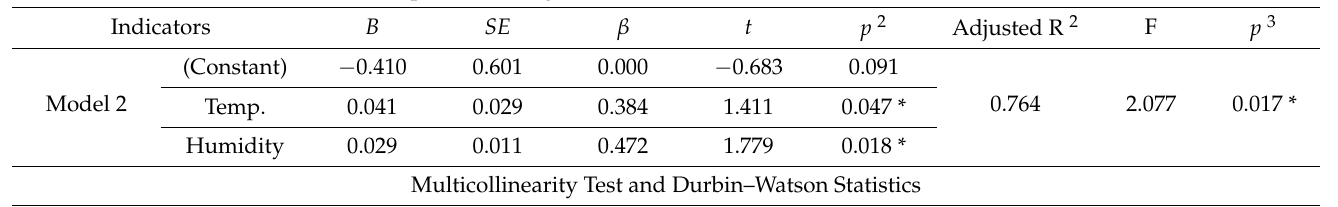
Table 6. Cont. Multiple Linear Regression and F-Test of Model 1 and Model 2